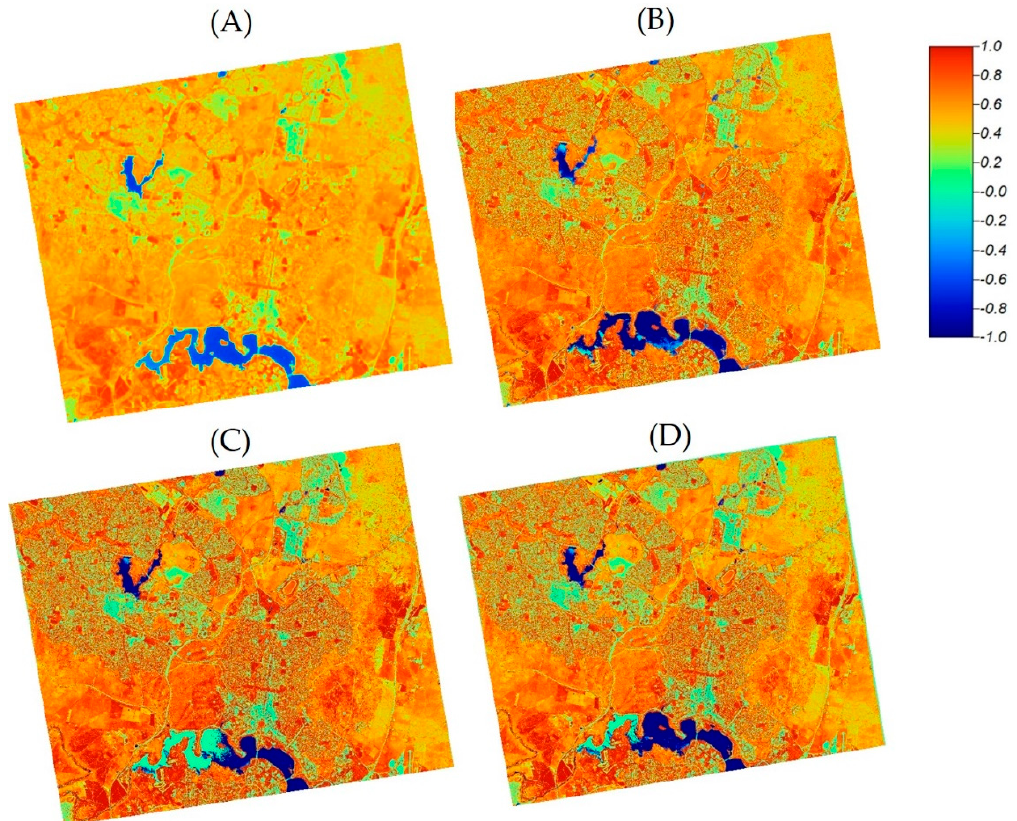
Figure 7. The NDVI results using red and near infrared (NIR) bands: ( a ) the Landsat-8 surface reflectance tier 1 in the Google Earth Engine (465 × 379), ( b ) the dark object subtraction (DOS)-based reflectance (6351 × 5171) of KOMPSAT-3A, ( c ) the TOC reflectance without the AERONET data (6351 × 5171) of KOMPSAT-3A, and ( d ) the TOC reflectance with the AERONET data (6351 × 5171) of KOMPSAT-3A.